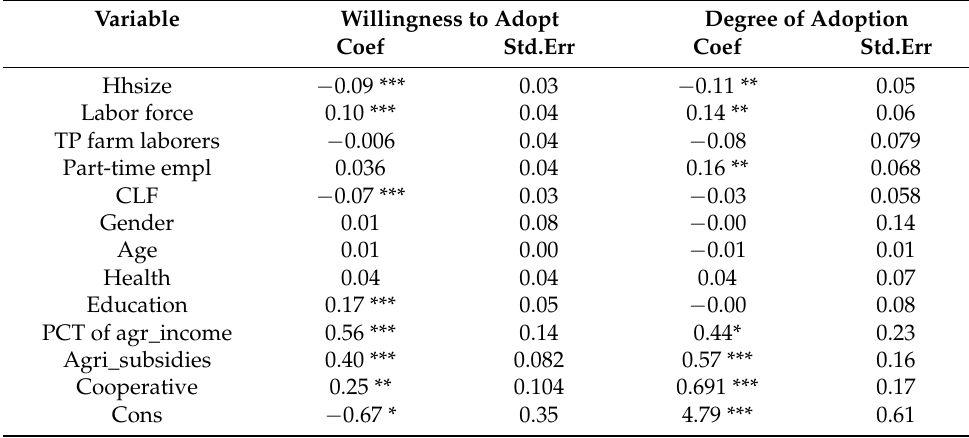
Table 4. Heckman model validation